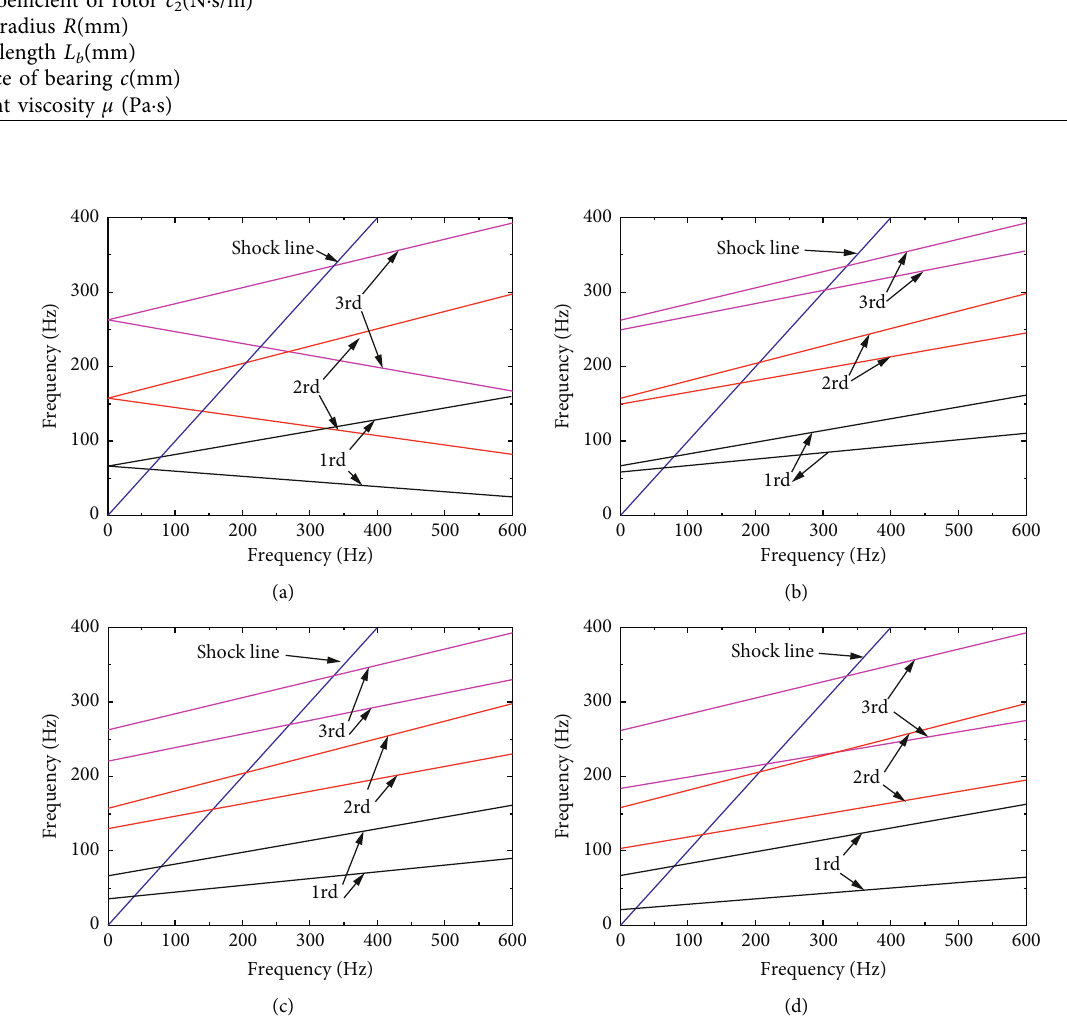
Figure 9 is the bifurcation diagram of dimensionless horizontal displacement X 1 at the right bearing location � 10 k ′ . It can be seen from Figure 9 that the bi- for k 2 2 furcation diagrams of the system have a little difference.